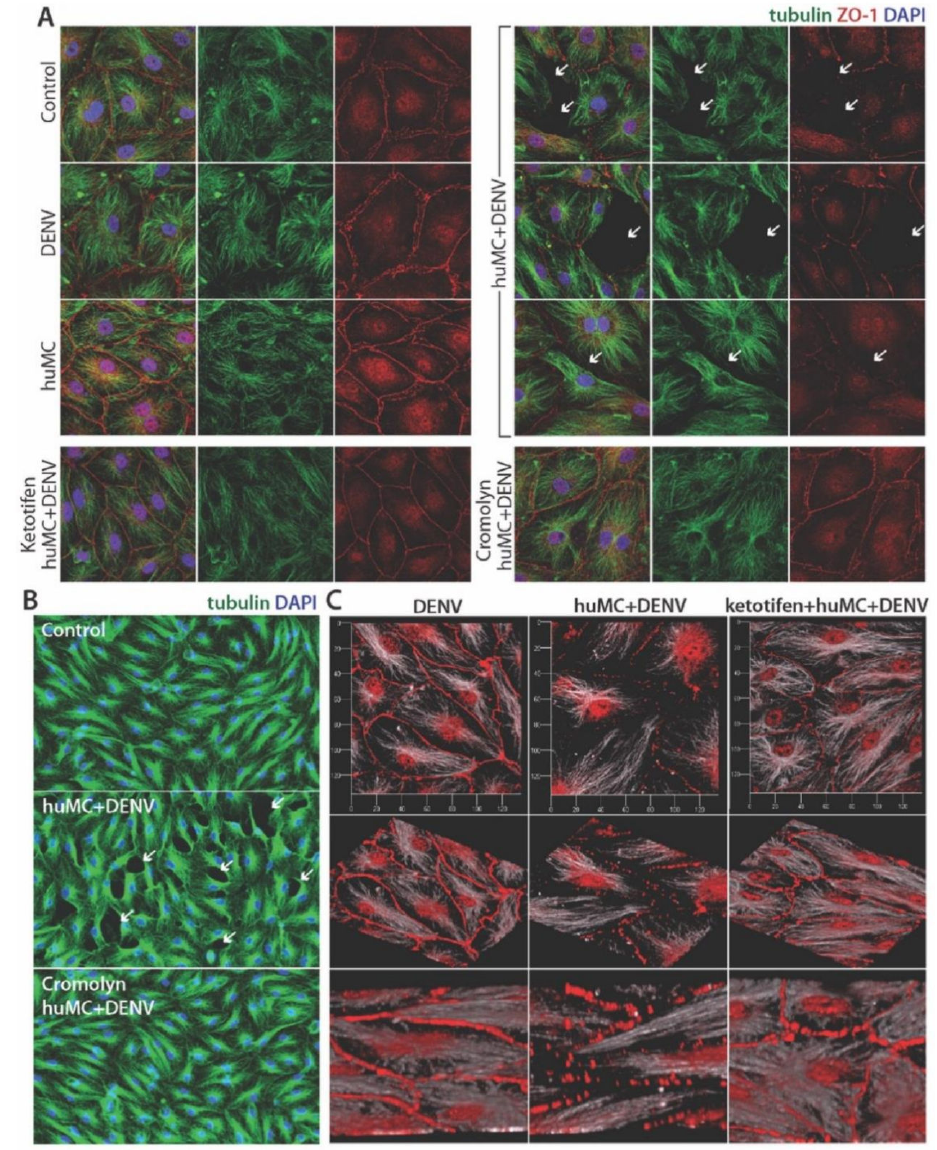
Figure 6. Tight junction breakdown due to DENV-induced MC products is prevented by MC stabilization. ( A ) huMEC monolayers were treated for 24 h with either media alone (control), DENV alone (3 × 10 6 pfu / mL), media from untreated huMCs, media from DENV-treated huMCs, (3 × 10 6 pfu / mL; MOI = 1), or DENV-treated huMCs that had been pretreated with MC-stabilizing drugscromolynorketotifen. Monolayerswerethenimagedat63 × magnificationbyconfocalmicroscopy, after staining for cellular structures including the microtubule networks (tubulin, green), the cell nucleus (DAPI, blue), and tight junctions (ZO-1, red). Regions where adjacent cells appear separated or cells appear to have lifted o ff of the coverslip surface are denoted with white arrows. ( B ) Widespread gap formation between cells in huMEC monolayers treated with DENV-induced MC products can be observed at lower (20 × magnification), compared to untreated control groups and cromolyn-pretreated groups. ( C ) 3D-reconstructions were made from z-stacks of huMC monolayers. Here, the cell shape and tight junctions are shown through staining with ZO-1 (red) and tubulin (white). For cells exposed to huMC products after DENV treatment, punctate staining could be observed along cellular junctions, whereas, for the DENV alone control and ketotifen treated MC + DENV groups, thick and uninterrupted staining for tight junction marker ZO-1 appears at cellular